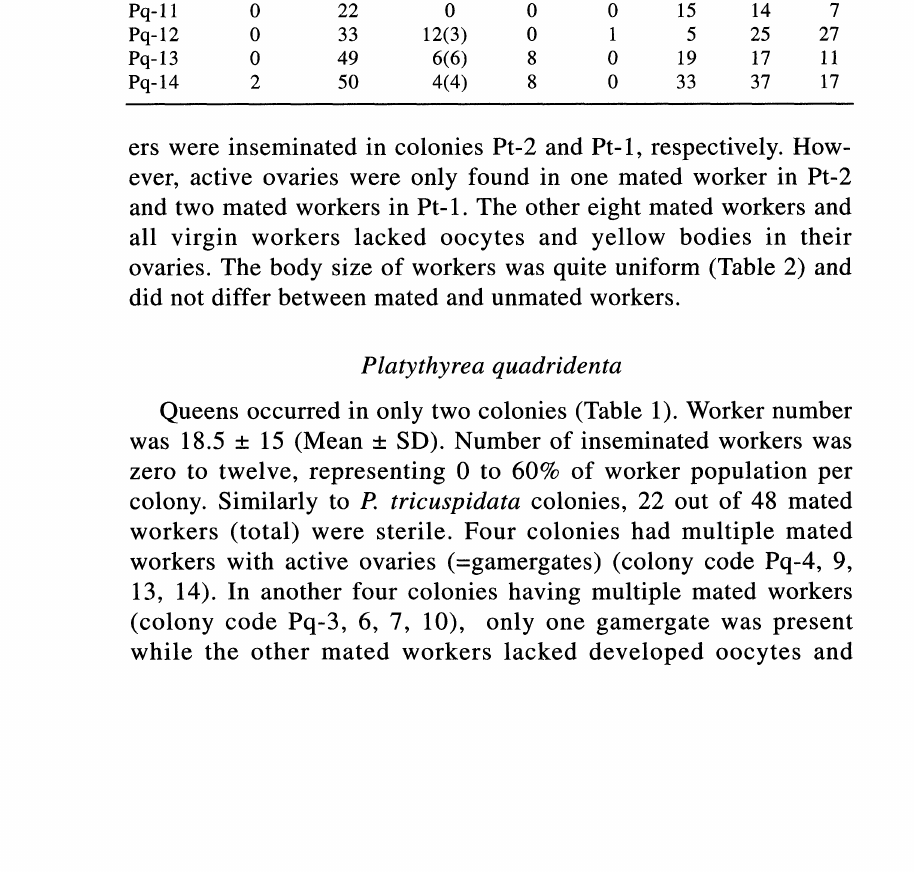
Table 1. Colony composition of Platythyrea tricuspidata (Pt-l,2) and P. quadri- denta (Pq-l-14) collected in West Malaysia.* Number of mated workers having active ovaries was shown in parentheses. Only one dealated queen was mated and had active ovaries. **Not counted just after sampling. Number of Individuals